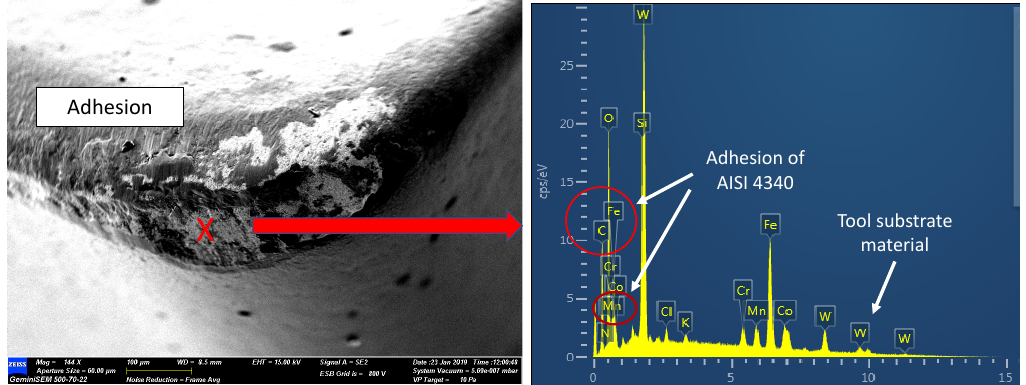
Figure 5. Adhesion wear on the flank face and EDAX analysis: Experiment Figure 5